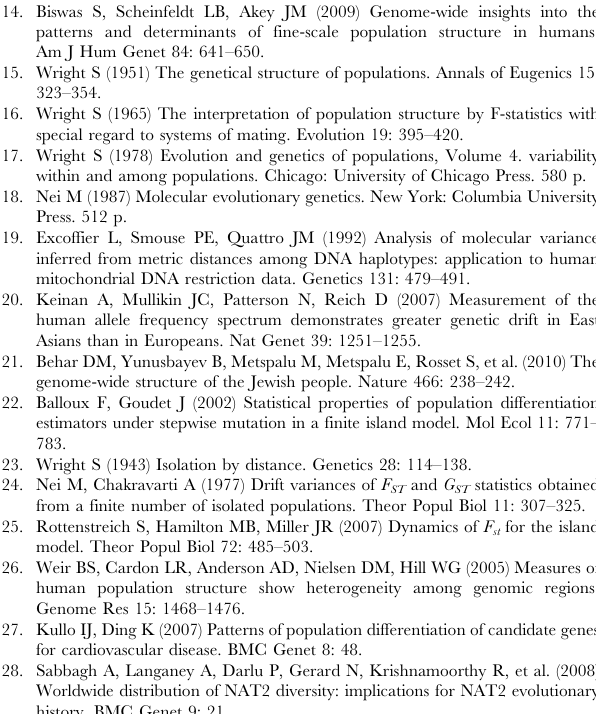
populations is plotted as a function of physical distance on a log- scale for five allele frequency groups (a–e). To simplify the presentation, the mean and standard error of the mean r 2 for the F ST . threshold SNPs (blue) and F ST , threshold (red) are presented for different between-SNP distances (50 bp, 100 bp, 1 kb, 5 kb, are marked as green dots. Table S1 Summary of HapMap phase 3 (second draft) data used in our analyses. The number of SNPs that passed or failed QC ++ (top) and the number of unrelated samples that passed or failed QC ++ (bottom). Table S2 Summary of SNP statistics per chromosome. Number of SNPs segregating in all samples within the continental dataset, SNPs density, mean and standard deviation of MAF, and mean and standard deviation of F ST for each